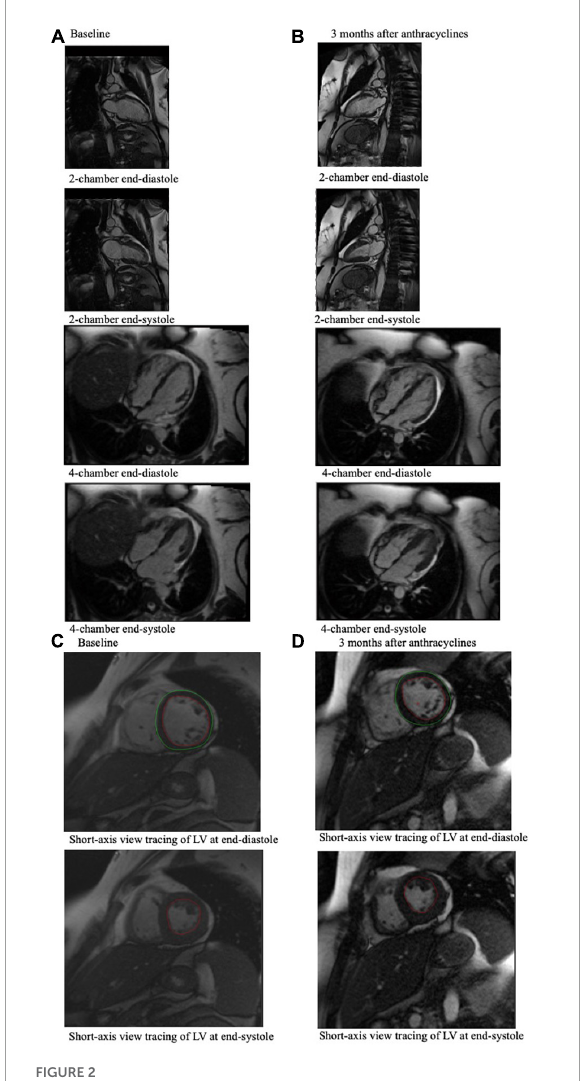
FIGURE2 CMR end-diastole and end-systole frames from a cine loop for a 49-year-old breast cancer patient who experienced an associated LVEF decline from 61% at baseline (A) to 43% 3 months after anthracycline-based chemotherapy (B) , which was measured using these CMR images. (A) Shows 4-chamber and 2-chamber view CMR imaging of the cancer patient pre- chemotherapy, and (B) shows CMR imaging of the same cancer patient 3 months after chemotherapy. (C) Shows the short-axis view tracing of the LV at end-diastole and at end-systole at baseline, which can be compared to (D) which shows short-axis view tracings of the LV at end-diastole and end-systole of this patient at 3 months after chemotherapy. In these tracings, the red tracing outlines the blood pool in the left ventricle, and the green tracing outlines the left ventricle. These tracings, which indicate LVEDV and LVESV, are used to calculate